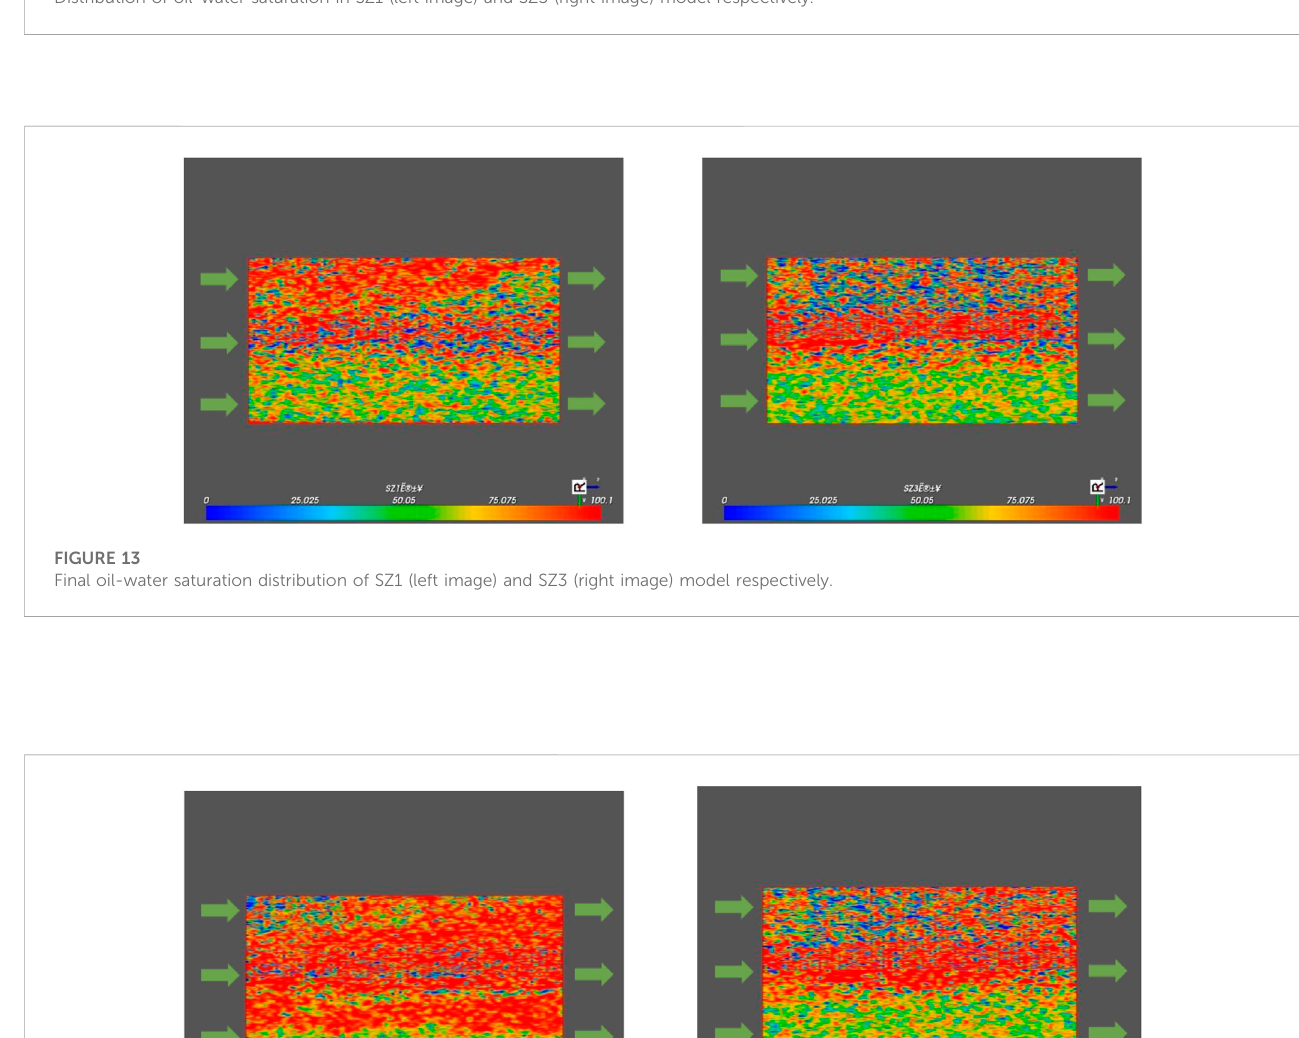
FIGURE 12 Distribution of oil-water saturation in SZ1 (left image) and SZ3 (right image) model